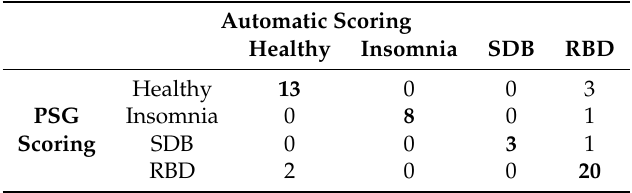
Table 8. Confusion matrix of an automatic classification